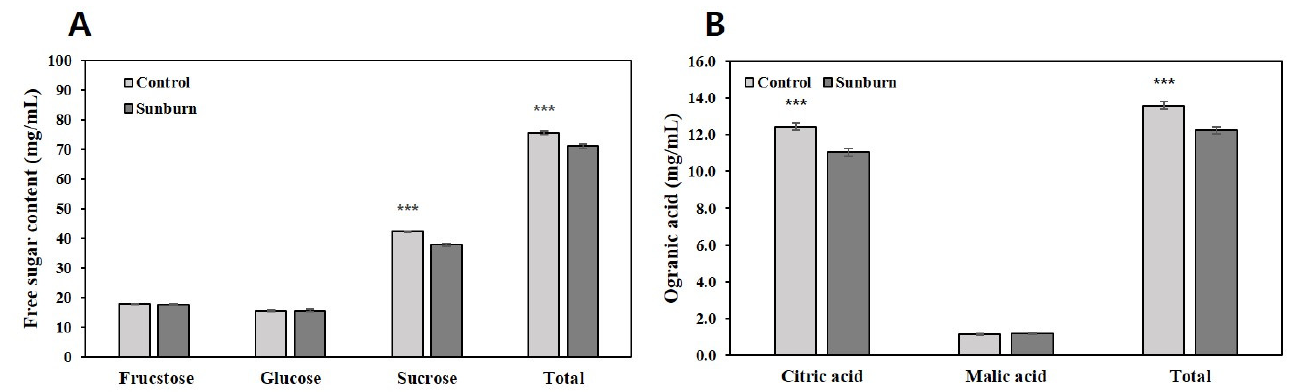
Table 2. Physicochemical analysis of sunburned and non-sunburned fruits of Citrus unshiu ‘Nichi-